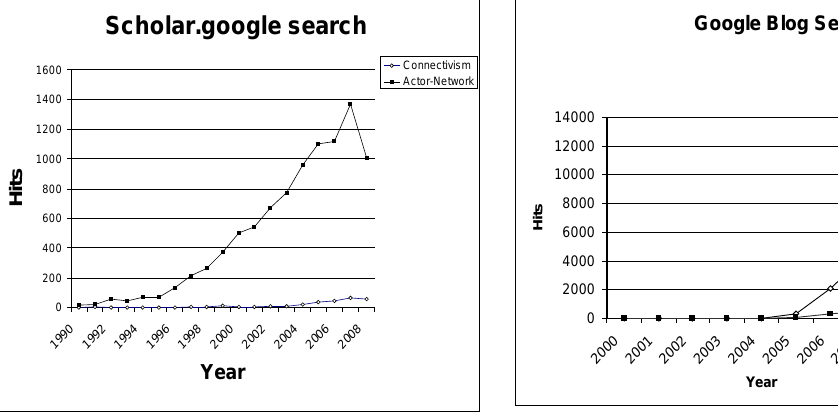
Figure 4 . Google Blog Search for connectivism and actor-network